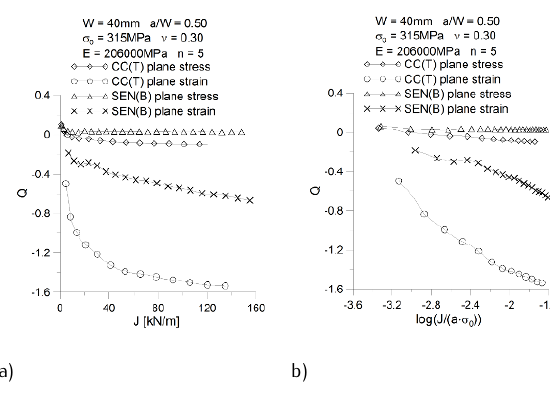
Figure 4. The comparison of the J - Q trajectories (a) and Q =f(log( J /( a ·σ 0 ))) trajectories (b) for CC(T) and SEN(B) specimen measured at the distance r =2.0 · J / σ 0 near the crack tip.